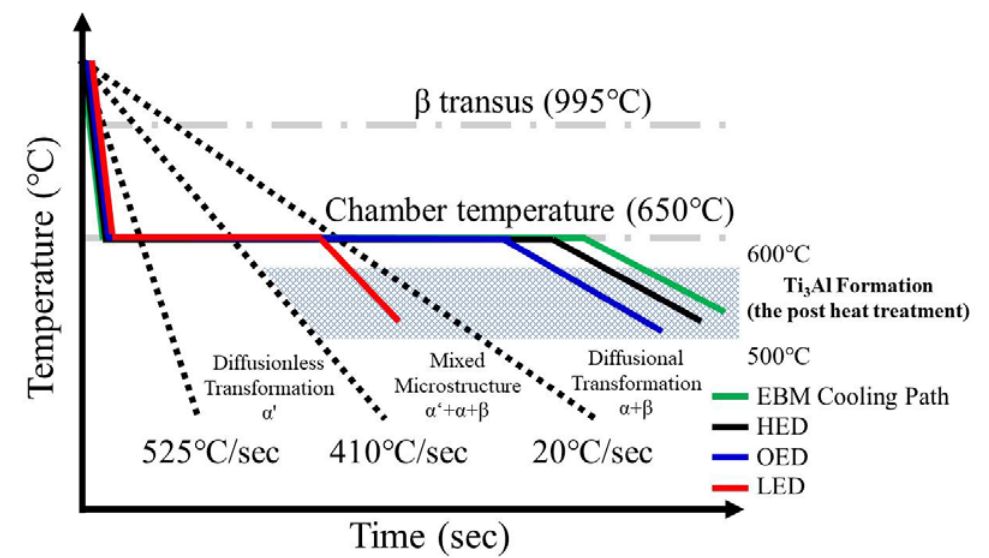
Figure 8. Prediction cooling path and phase transformation based on the literature [19] of LED, OED and LED parameters built in top, middle and bottom of the specimen respectively. The difference in cooling rate result from different energy density and spatial location thus contribute to different microstructure. i.e., α′ + α + β in LED built zone, α + β lamella structure in the OED built zone and α + β + Ti 3 Al intermetallic phase in the HED built zone were observed.